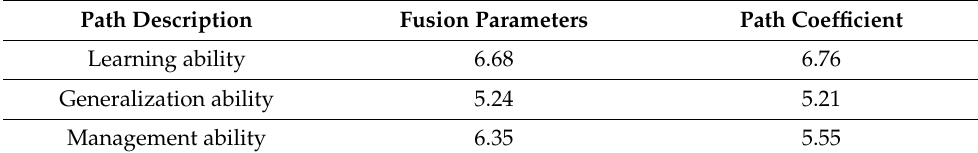
Table 1. Information fusion parameter estimation and significance test.